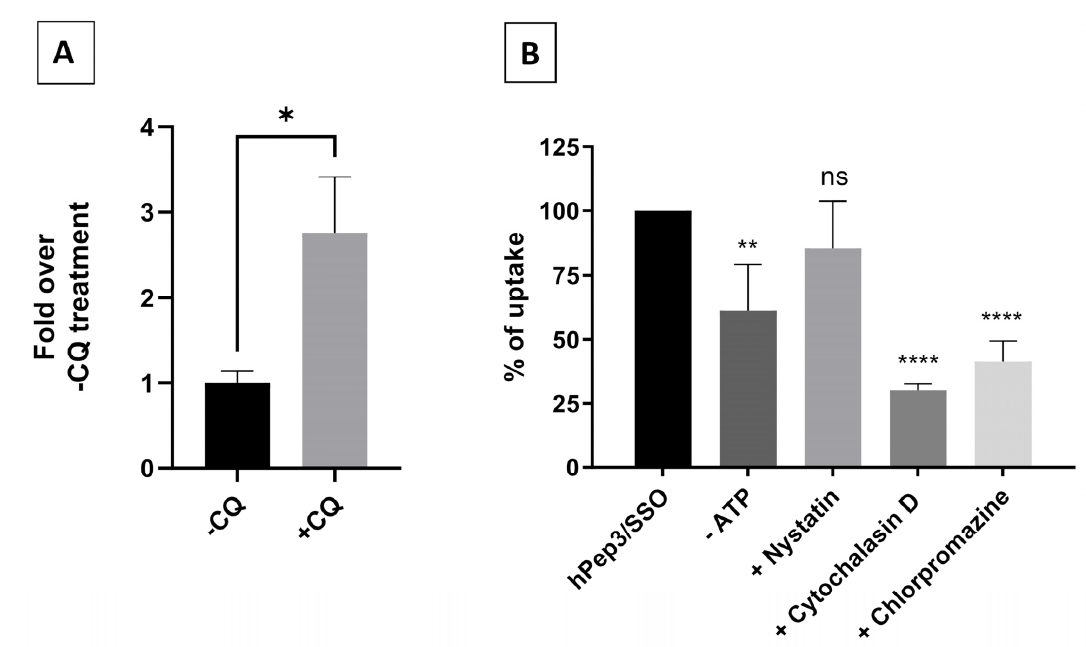
Figure 6. Cellular trafficking of hPep3/SSO nanoparticles in HeLa 705 cells. ( A ) Cells were treated with a 200 nM of hPep3/SSO nanoparticles for 4 h with (+CQ) or without (-CQ) chloroquine treatment and luminescence activity was measured 18 h later. The values are the mean of at least the three experiments (mean ± SEM). p -values were determined by the independent t -test (* p < 0.05). ( B ) Impact of endocytosis inhibitors and energy depletion to the uptake of hPep3/AF568-SSO complexes. For inhibition the following inhibitors were used: 2 ′ -Deoxy-D-Glucose and NaN 3 for ATP-depletion (- ATP); nystatin for caveolae-mediated endocytosis inhibition; and cytochalasin D for micropinocytosis; and chlorpromazine for clathrin-mediated endocytosis inhibition. The values are the mean results of at least three independent experiments (mean ± SEM). p -values were determined by the one-way ANOVA with Dunnett’s multiple comparison test (ns—non-significant, * p < 0.05, ** p < 0.01 and **** p < 0.0001).